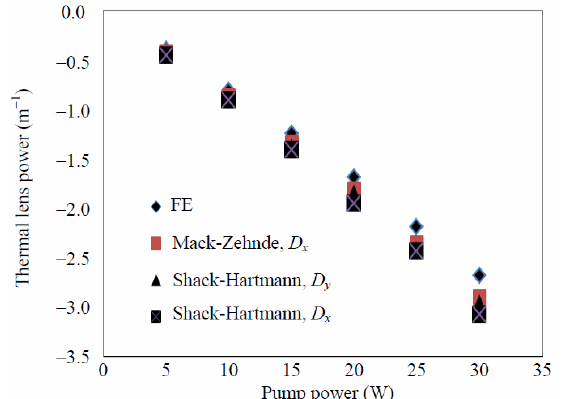
Fig. 9 Comparison between FE simulations and experimental